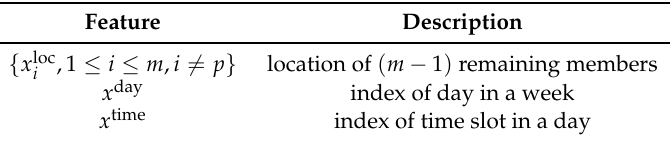
Table 2. Elements of the input vector in the first phase of the model for predicting the location of person p